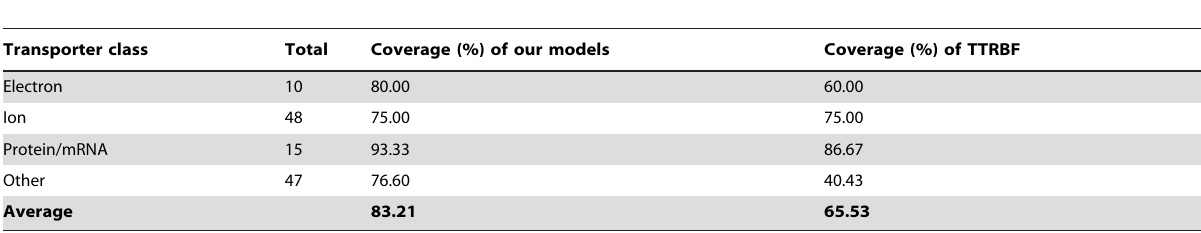
Table 5. A comparison of the coverage metric of our models with TTRBF.